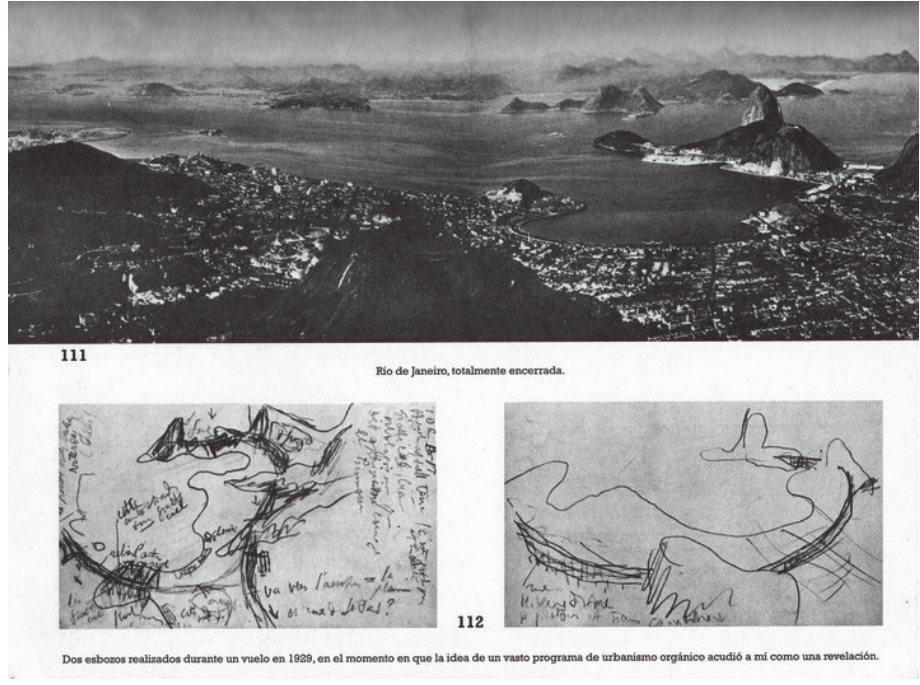
Fig. 3. Le Corbusier, Aircraft, (1935). Figures 111 y 112: “ two sketches made during a flight in 1929,